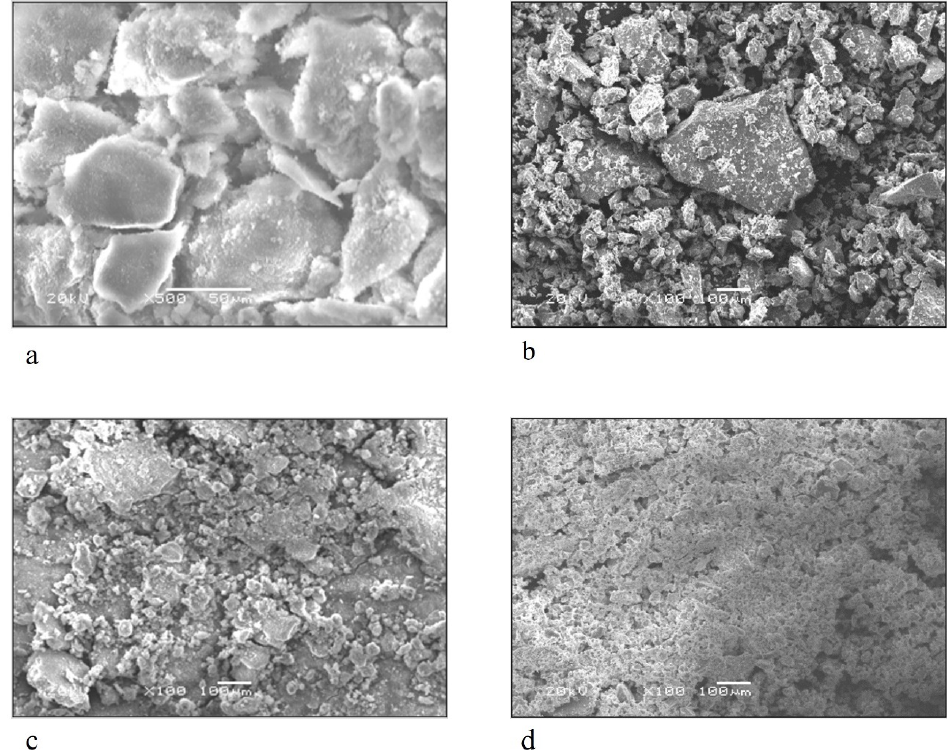
Figure 5. ( a ) represents SEM of synthesized MgAl-LDH (MgLDH), ( b ) represents SEM of synthesized NiAl-LDH (NiLDH), ( c ) represents SEM of synthesized MgAl-LDH intercalated green tea oil (MgLDH-GT), ( d ) TEM of synthesized NiAl-LDH intercalated green tea (NiLDH-GT).